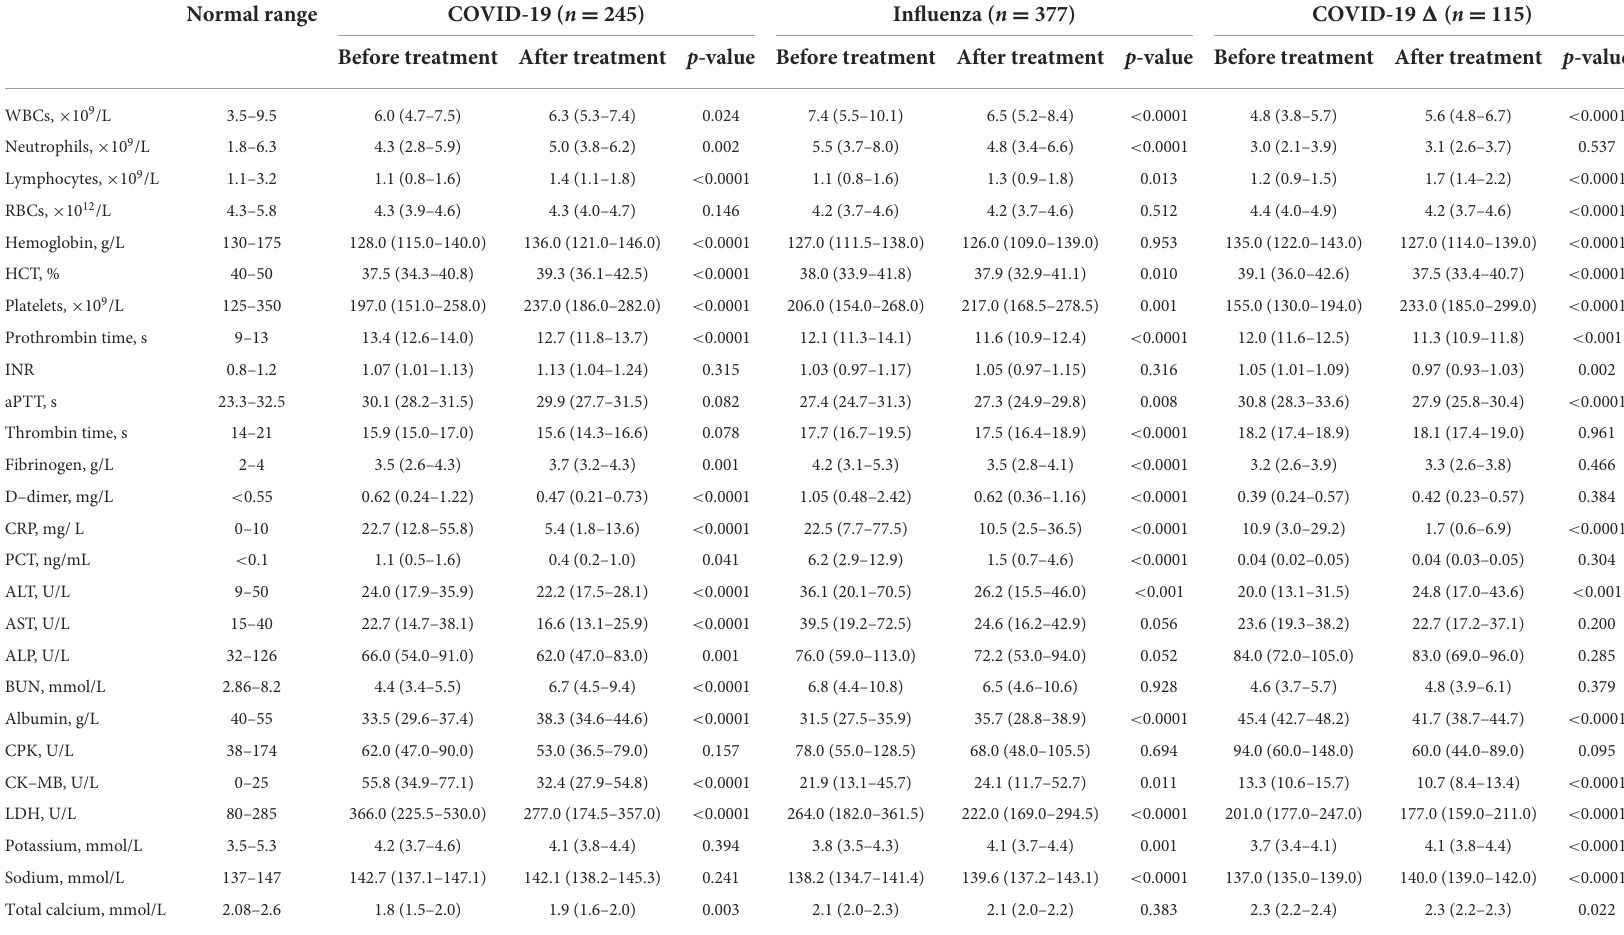
TABLE 5 Blood parameters of patients in the COVID-19 cohort, the influenza cohort, and the COVID-19 1 cohort, before and after individual treatment. Normal range COVID-19 ( n = 245) Influenza ( n = 377) COVID-19 1 ( n = 115) Before treatment After treatment p -value Before treatment After treatment p -value Before treatment After treatment p